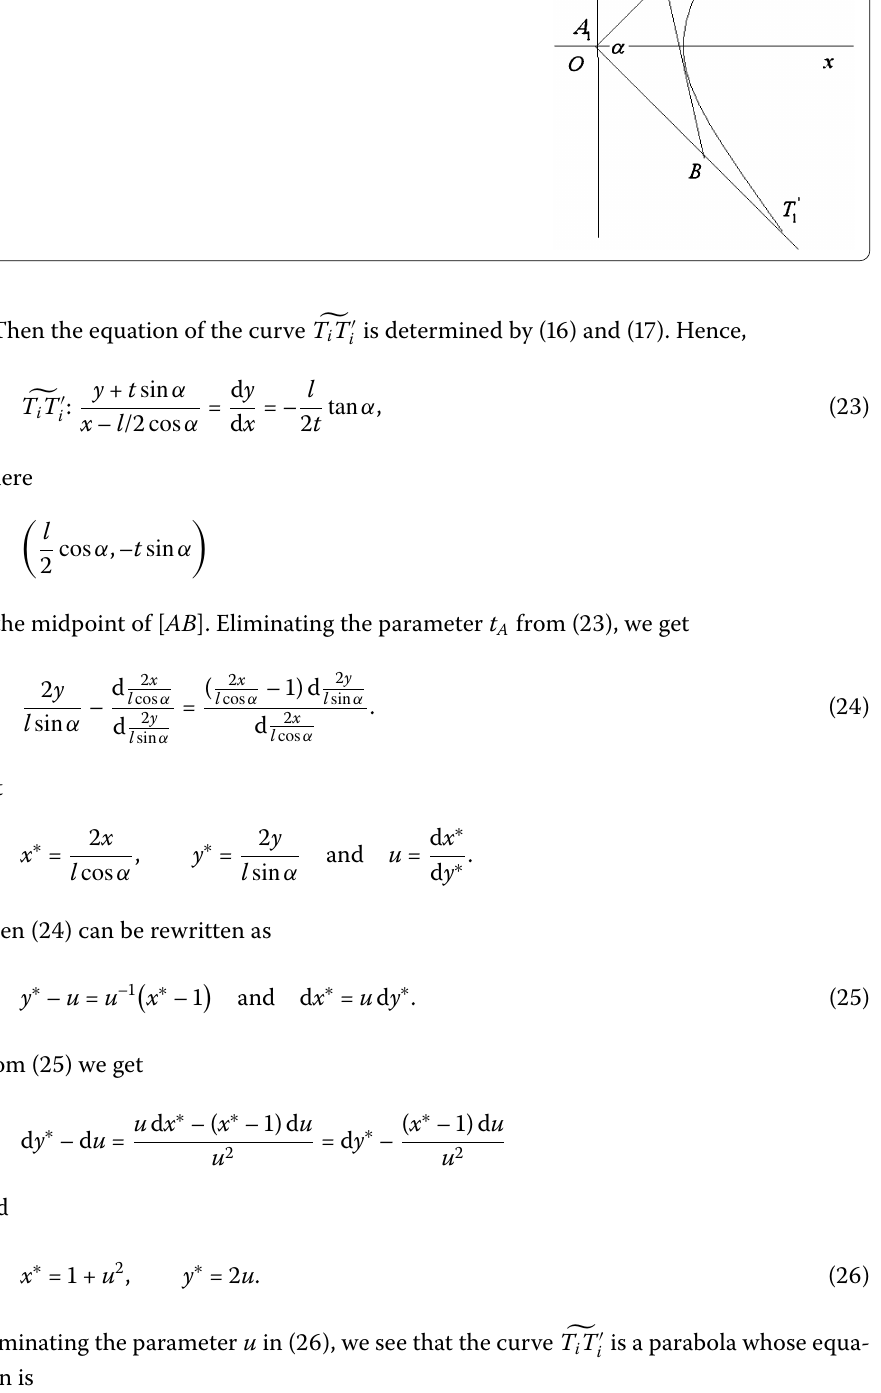
(cid:2) T 1 T (cid:2) 1